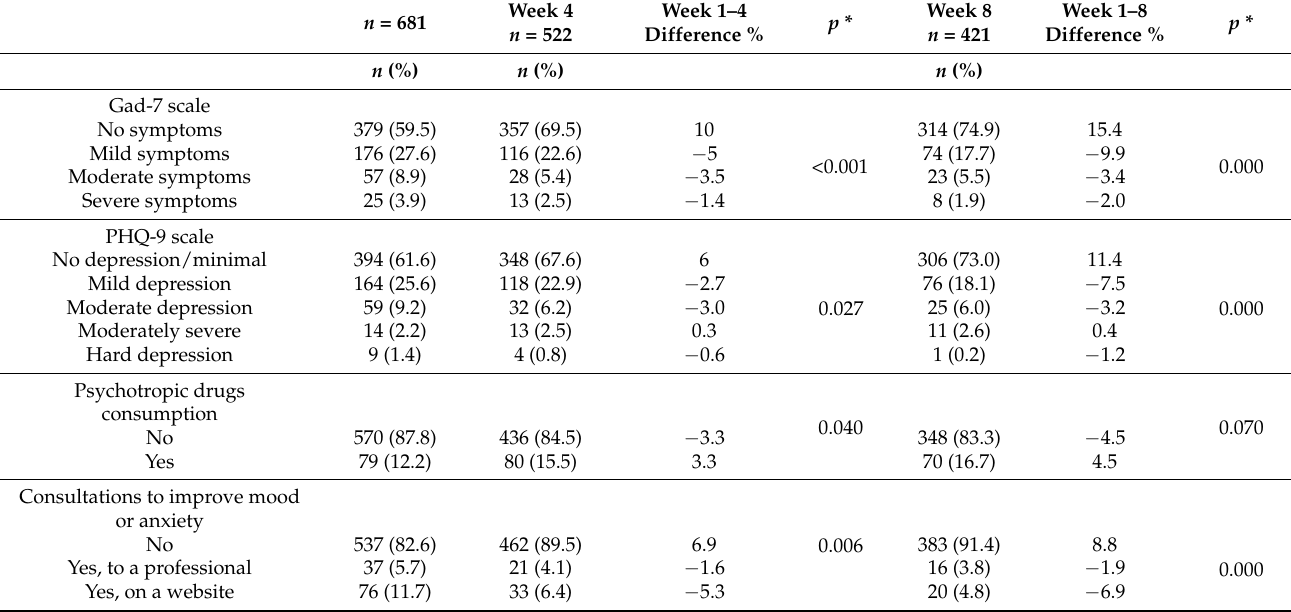
Table 3. Evolution of psychological wellbeing